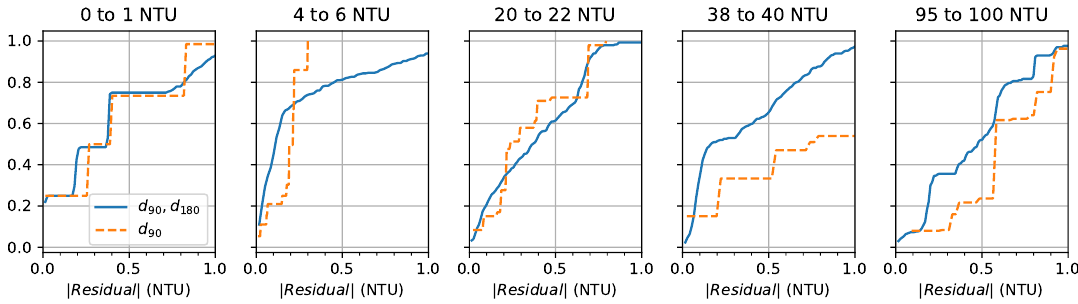
Figure 12. Cumulative distribution function of the absolute value of the residual by NTU range.